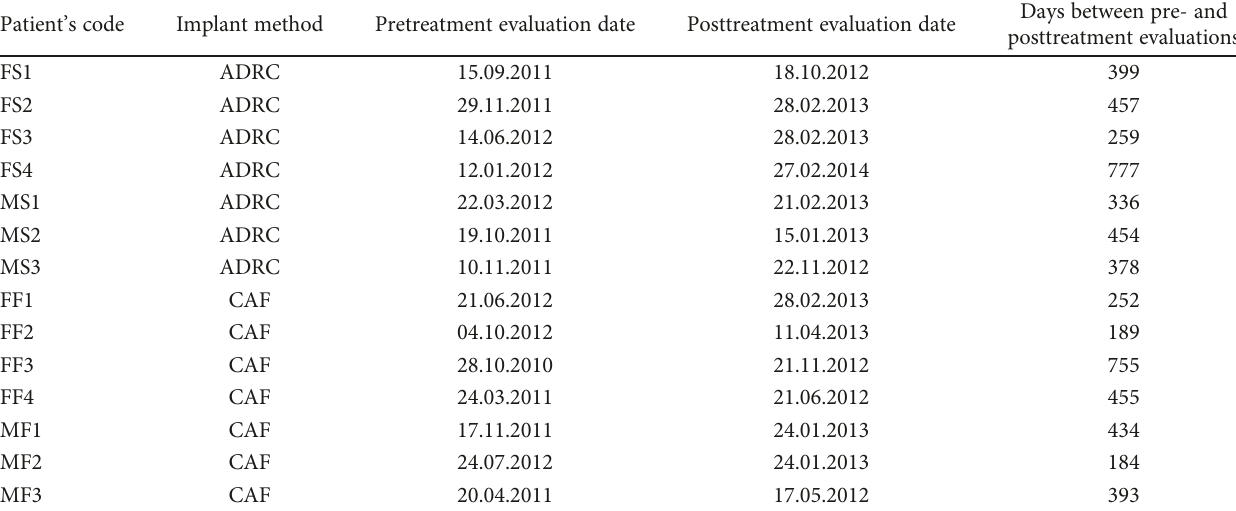
Table 6: Pre- and posttreatment evaluation dates.